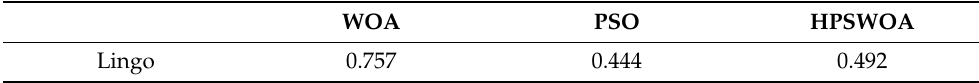
Table 5. Statistical test results of the best total cost obtained from Table